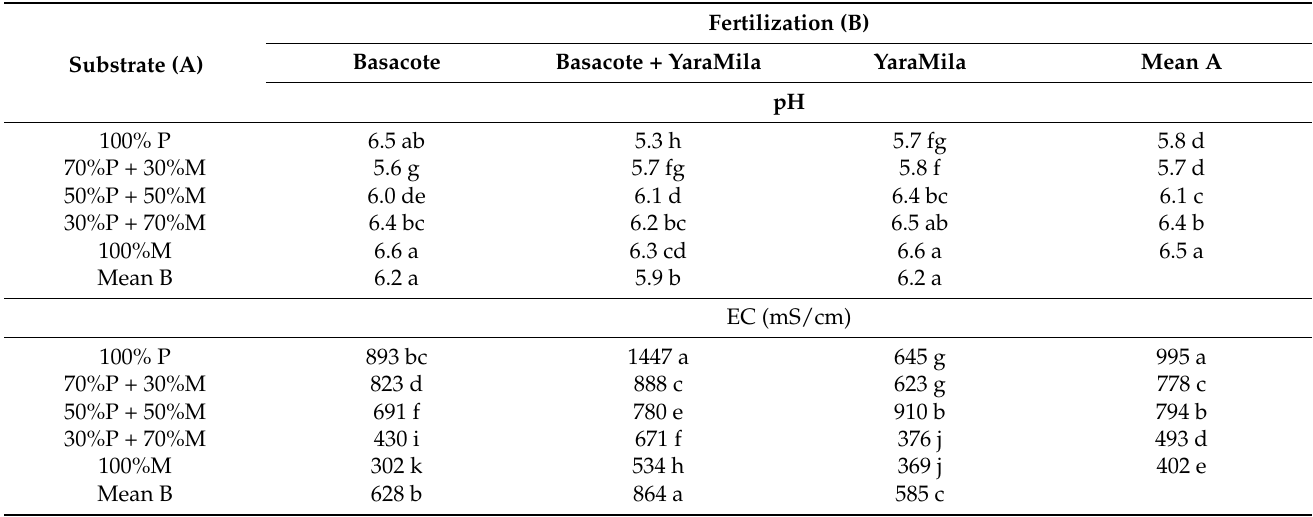
Table 12. pH and EC of substrates in Sedum spectabile ‘Stardust’ grown in containers with five different substrates.